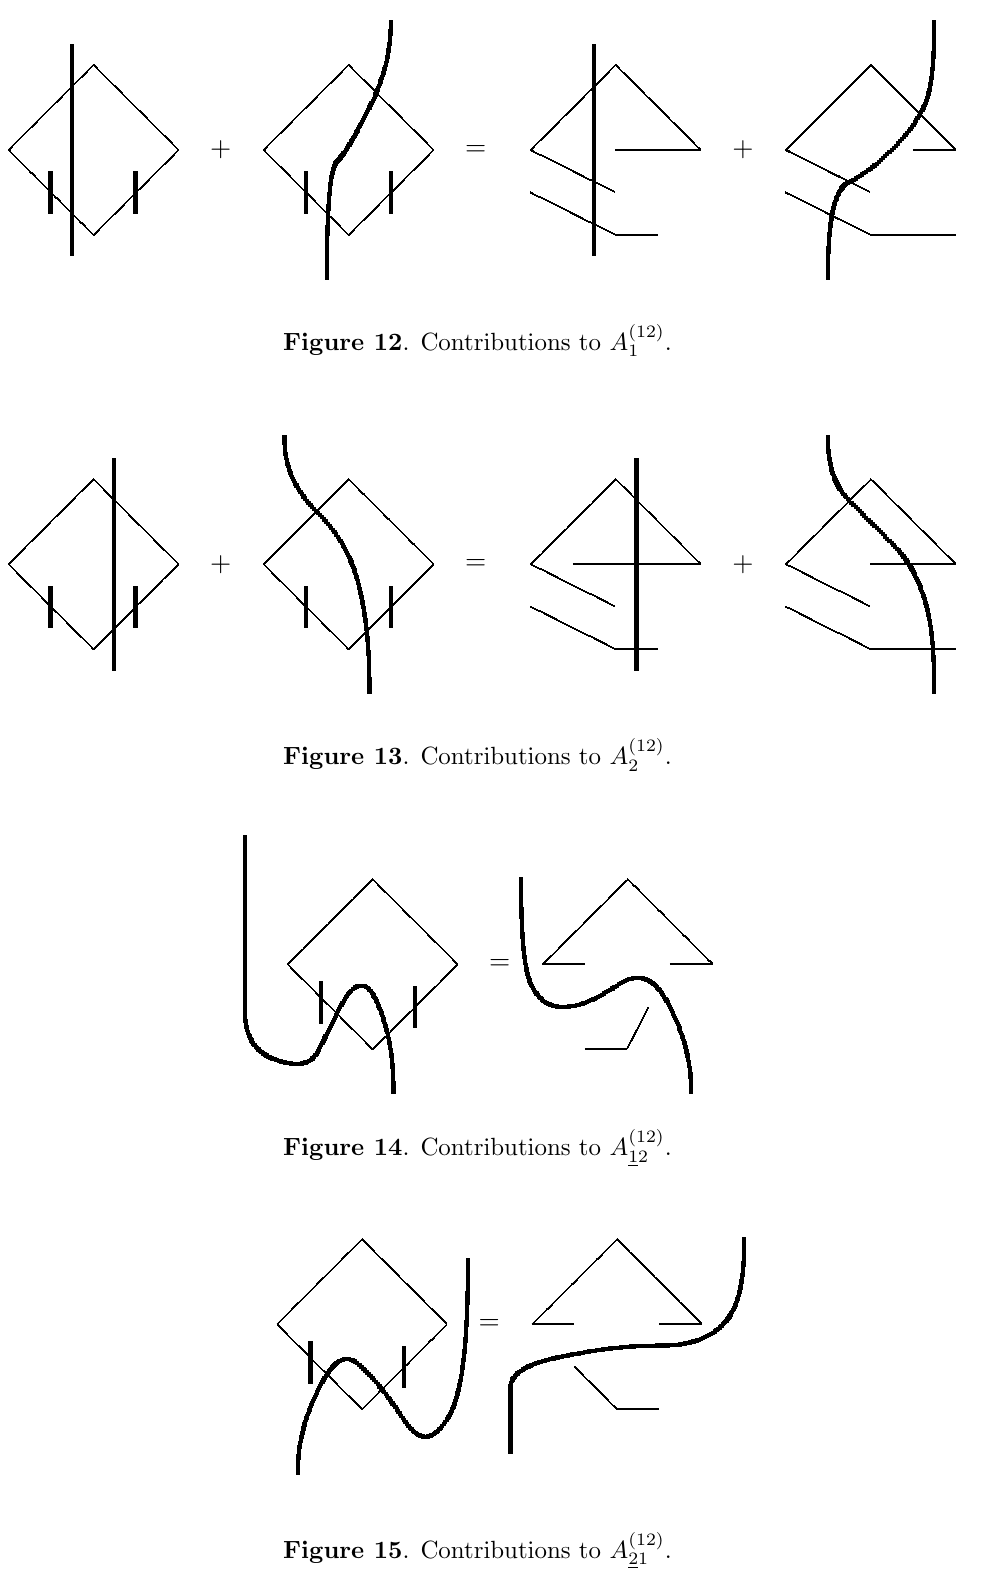
Figure 15 . Contributions to A (12)